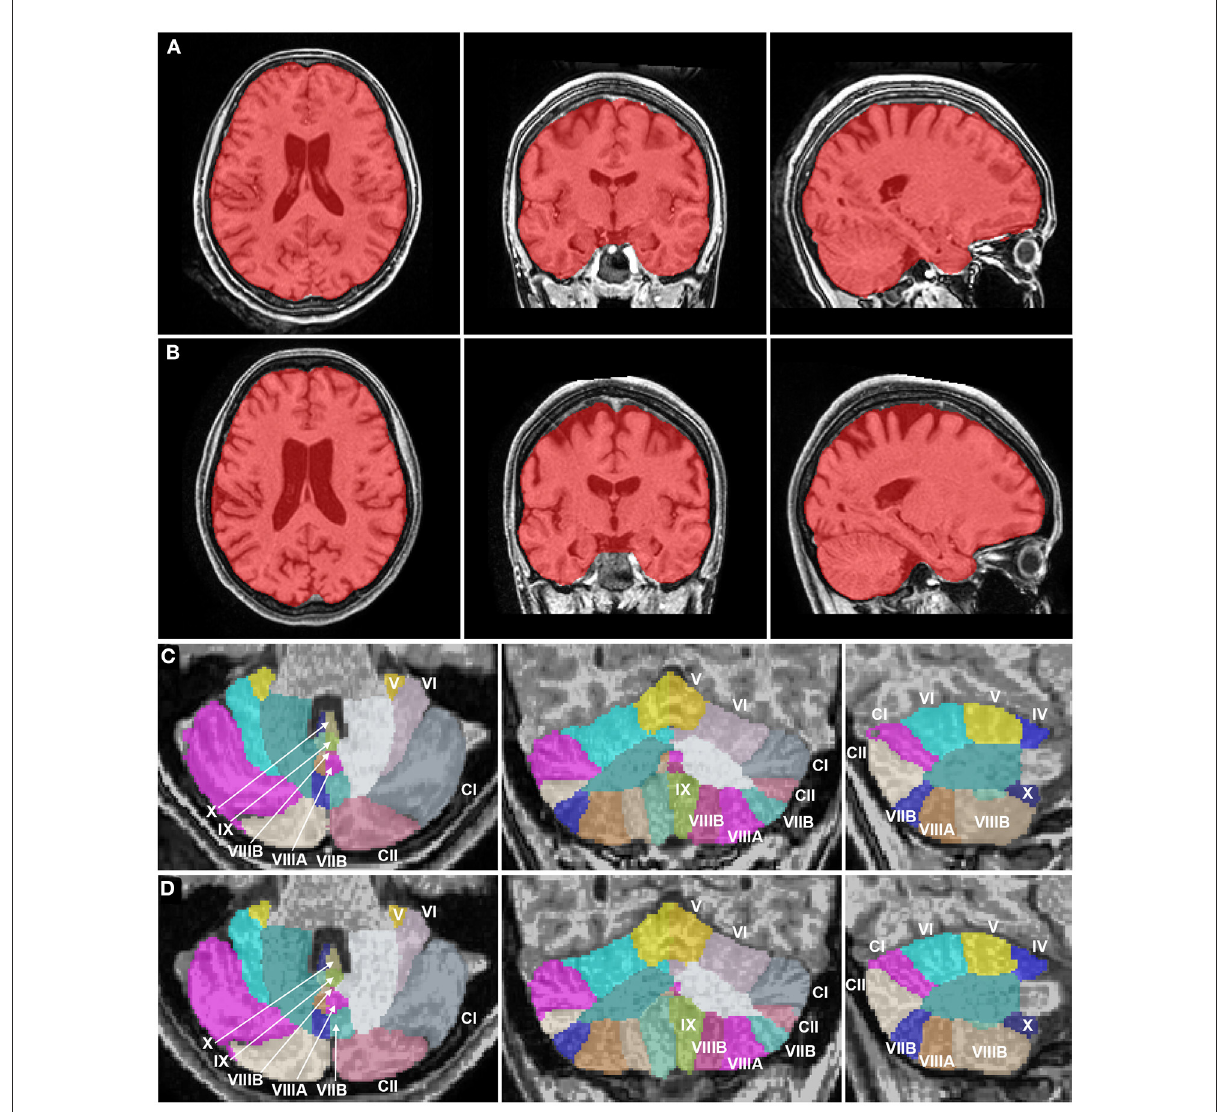
FIGURE2 Brain magnetic resonance imaging segmentation maps of the patient with juvenile Huntington’s disease at 18 years and 21 years. (A, B) Whole brain images (in red) of the patient in axial, coronal, and sagittal planes show an atrophy of the striatum at 18 years (A) , progressing to a more diffuse process of atrophy, including subcortical structures and neocortical areas like the frontal and parietal lobes at 21 years (B) . White matter volume was relatively preserved as compared to gray matter. (C, D) Cerebellum images of the patient in axial, coronal, and sagittal planes show a normal cerebellar volume and a volumetric stability at 18 years (C) and 21 years (D) . The Roman numerals of the cerebellar lobules were added. CI, Crus I; CII: Crus